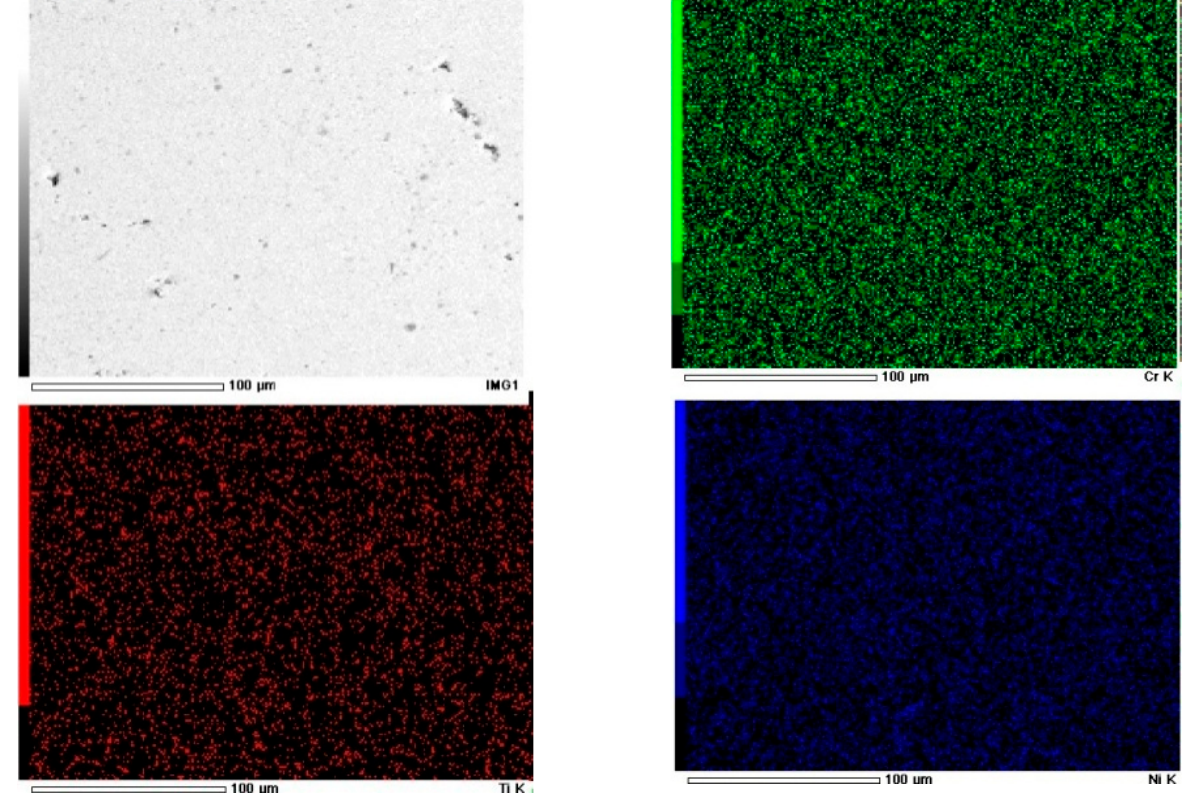
Figure 4. SEM image and surface scan energy maps of Incoloy 825 alloy layer (red color-Ti, blue color-Ni, and green color-Cr).